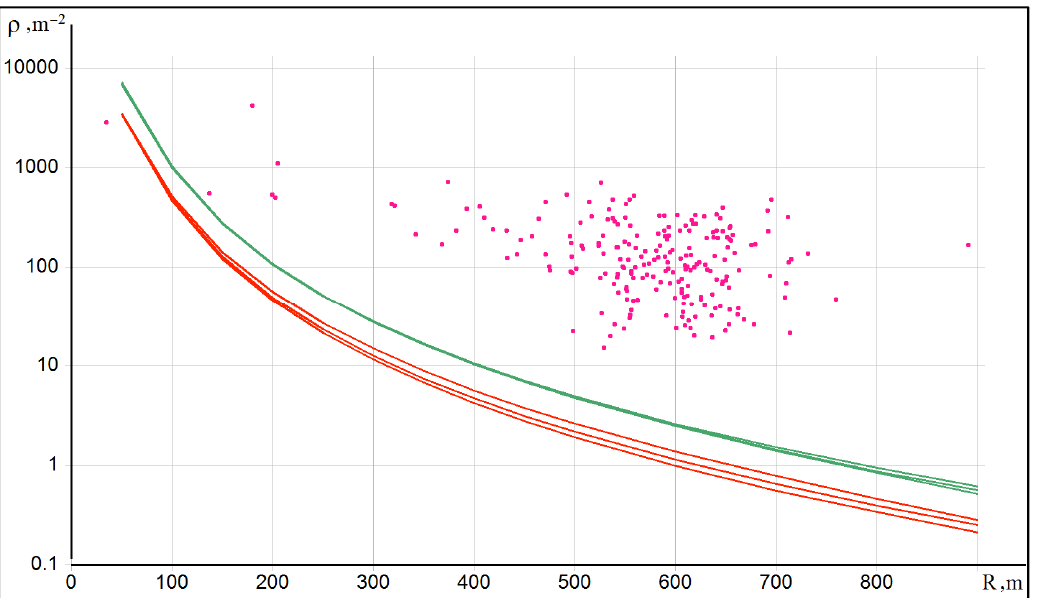
Figure 3. The distribution of the particle density ρ in dependence on the distance R in 217 multi-modal EAS events (scattered points), in comparison with the standard lateral distribution ρ (r) resulting from the CORSIKA simulation of the showers with primary energy 500 PeV (three lower curves) and 1000 PeV (upper curves).